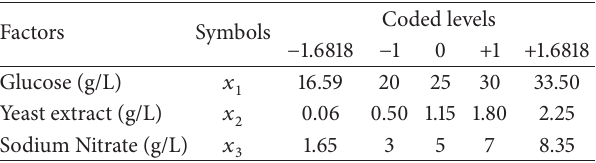
Table 1: Actual levels for independent variables (medium compo- nents) designed through CCD